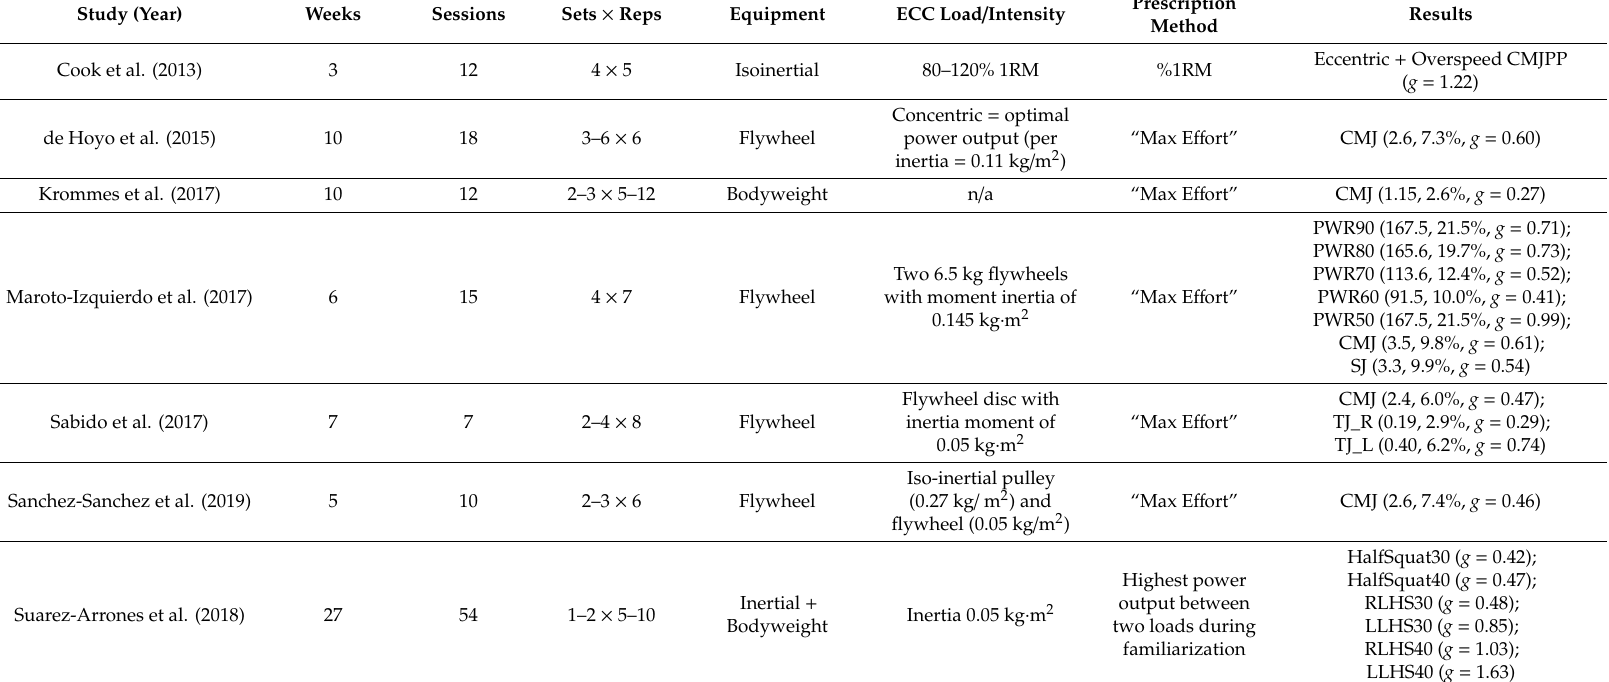
Table 5. Eccentric training intervention characteristics for power